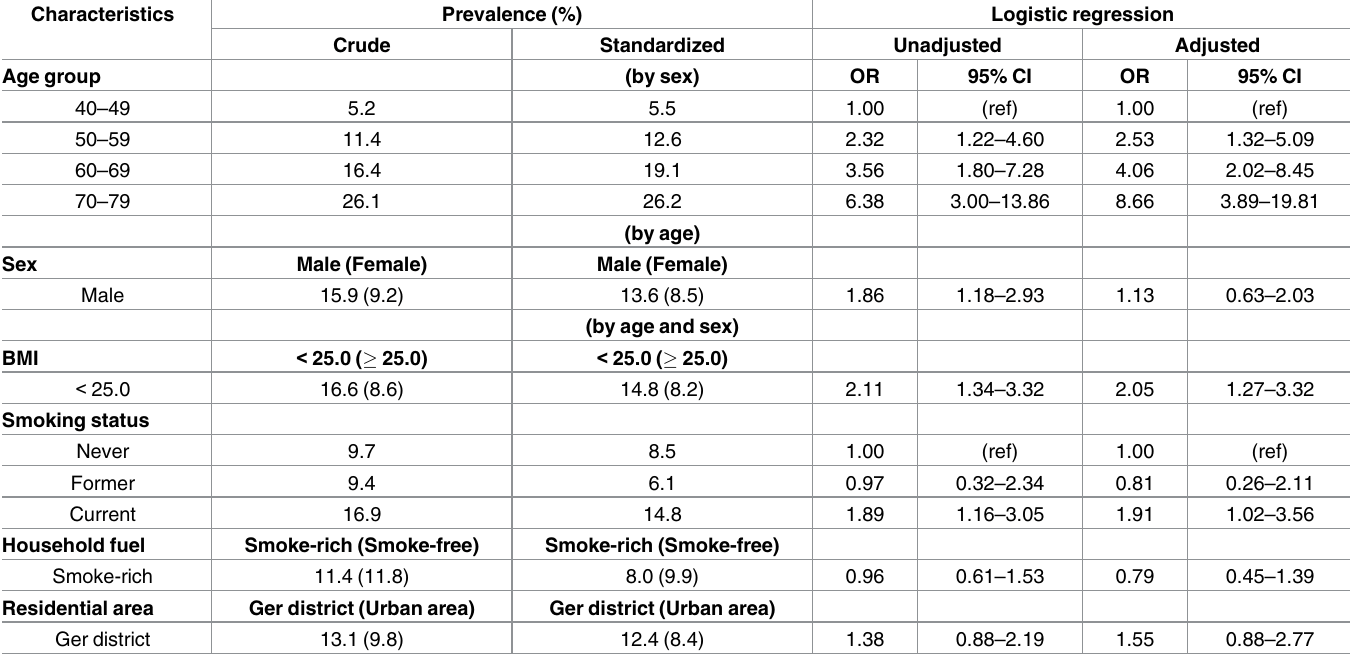
Table 3. Factors affecting the prevalenceof airflow